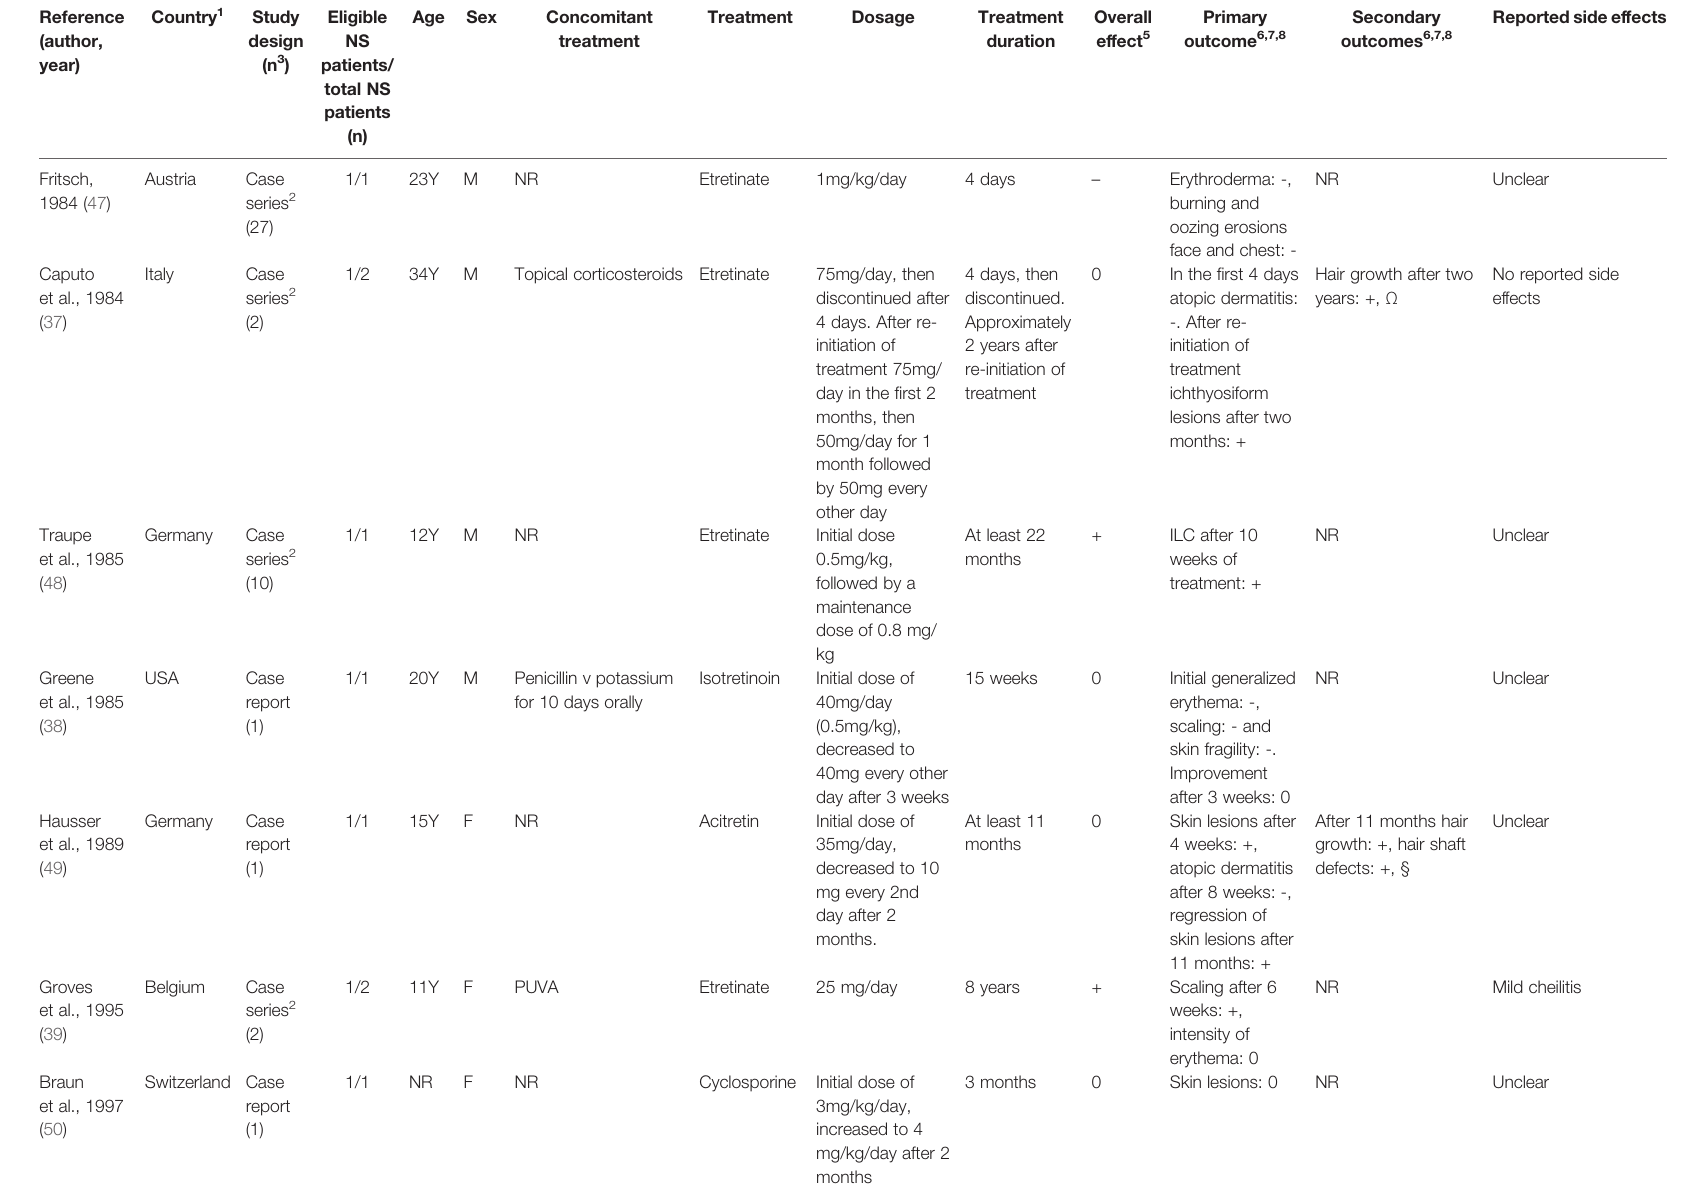
TABLE 1 | Characteristics of included studies evaluating systemic therapy in patients with netherton